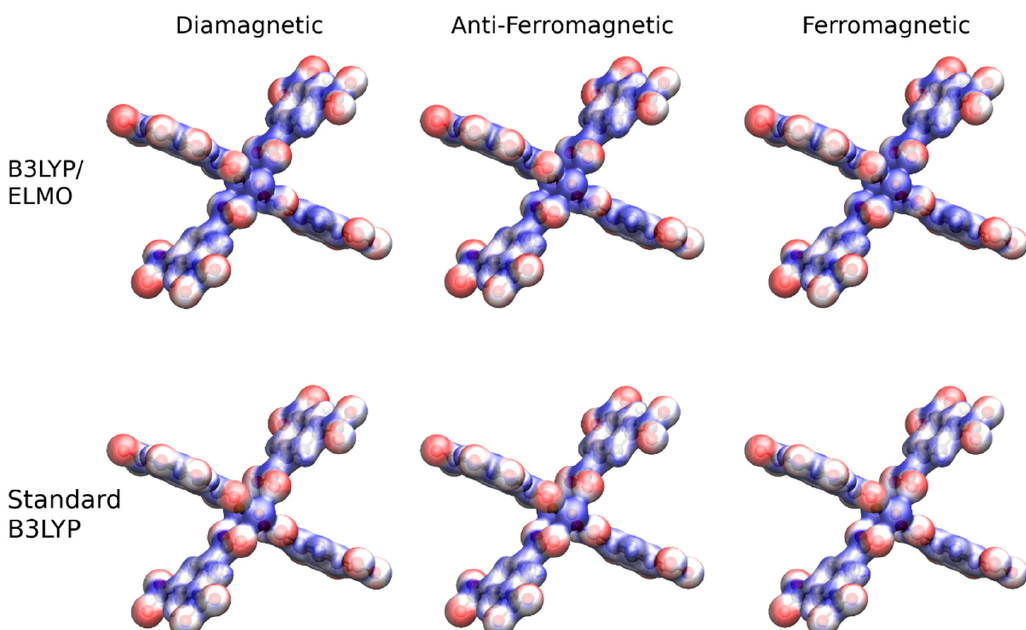
Figure 5. Electrostatic potential maps at different levels of theory with basis set 6-311G(2d,2p) for the model system extracted from the HKUST-1 experimental crystal structure with a water chemisorption degree of 14.3(6)%. The electrostatic potentials were plotted on the corresponding 0.05 a.u. electron density isosurfaces according to the RWB (red-white-blue) scheme over the range [-0.1 a.u., 0.1 a.u.].